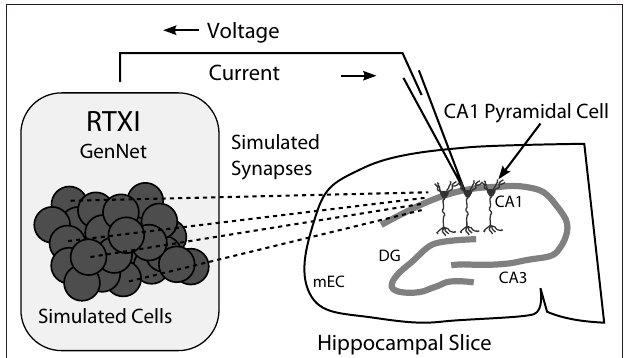
FIguRe 2 | Schematic diagram of a hippocampal hybrid network. A set of model cells simulated with GenNet within RTXI (shaded box on left) interacts with a real pyramidal neuron being recorded with the patch-clamp technique in a hippocampal slice (right). Dark circles represent individual model cells that are connected via virtual synapses (dashed lines) to a real pyramidal neuron. A patch-clamp pipette is used to record the voltage from this neuron in real time which is then passed as input to GenNet (upper arrow). After a computational time-step has elapsed, GenNet computes the synaptic current that must be passed to the pyramidal neuron and RTXI sends this current into the cell via the pipette (lower arrow). Multiple adjacent pyramidal neurons indicate that an arbitrary number of real cells can be embedded into the hybrid network. Abbreviations refer to the regions of the hippocampal formation: mEC, medial entorhinal cortex; DG, dentate gyrus; CA3, cornu Ammonis 3; CA1: cornu